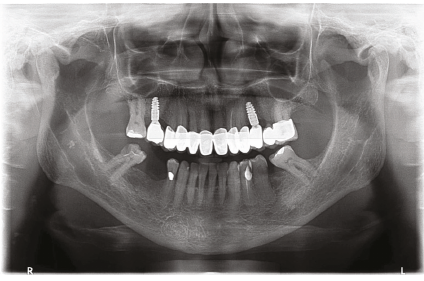
Figure 5: OPG 2 years after the